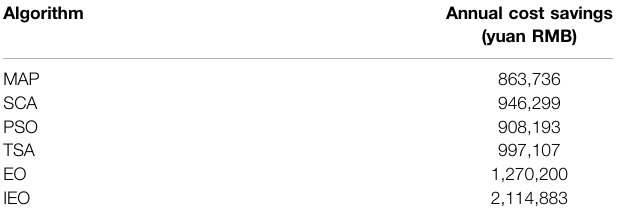
TABLE 6 | Analysis of annual cost savings. Algorithm